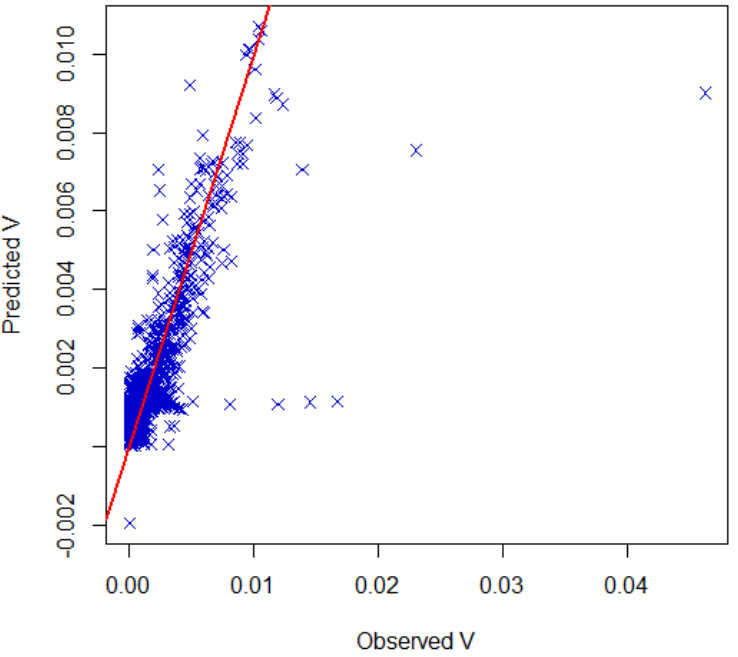
Figure 7. Comparison plot of predicted and observed settling velocity for the BPNN model with network architecture 4-7-1.